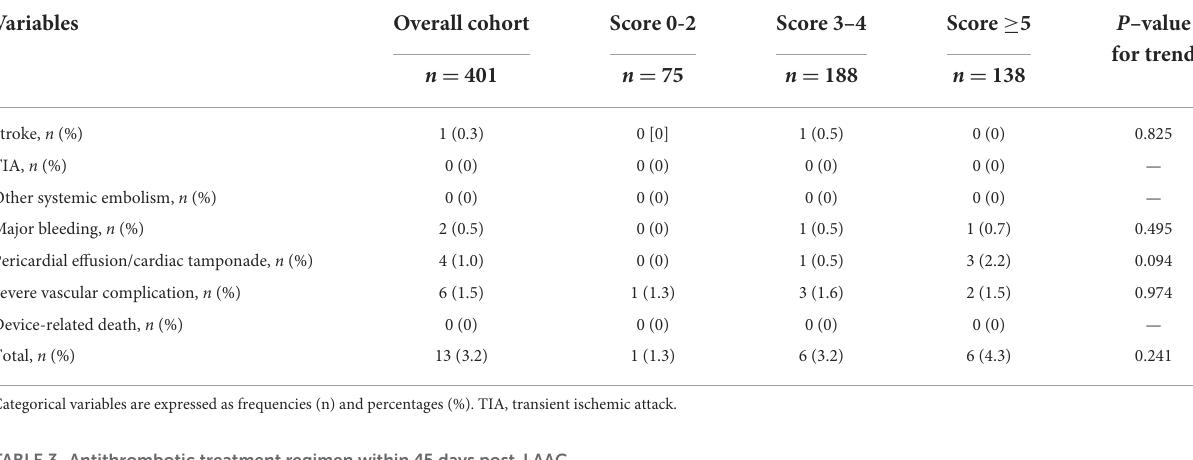
TABLE 3 Antithrombotic treatment regimen within 45 days